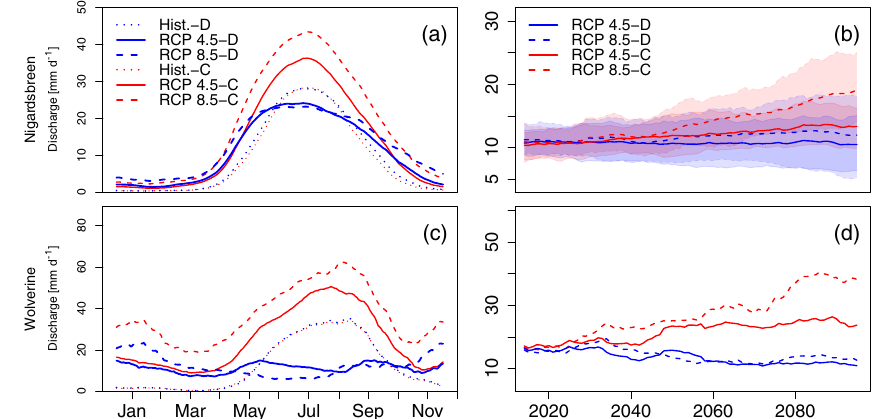
Figure 6. Future water availability. Panels (a) and (c) show the hydrological regime (30-day moving window of the daily average of 2071– 2100) for Nigardsbreen (a) and Wolverine (c) , and panels (b) and (d) the annual average discharges for the future period (2010–2100) with a 10-year moving window, for (b) Nigardsbreen and (d) Wolverine. Discharge is shown for both glacier area conceptualisations (colours) and both climate change scenarios (line type). The shaded areas in panel (b) indicate the spread in annual average discharges among the different climate model forcings.